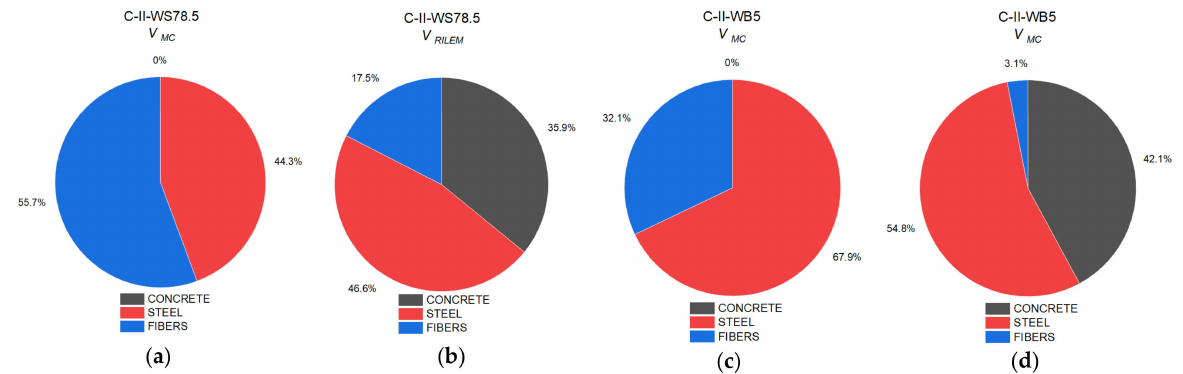
Figure 13. Proportion of the individual components of shear capacity of beams in the following series: ( a ) C-II-WS78.5 pursuant to fib Model Code 2010; ( b ) C-II-WS78.5 pursuant to RILEM TC 162-TDF 2003; ( c ) C-II-WB5 pursuant to fib Model Code 2010; ( d ) C-II-WB5 pursuant to RILEM TC 162-TDF 2003.